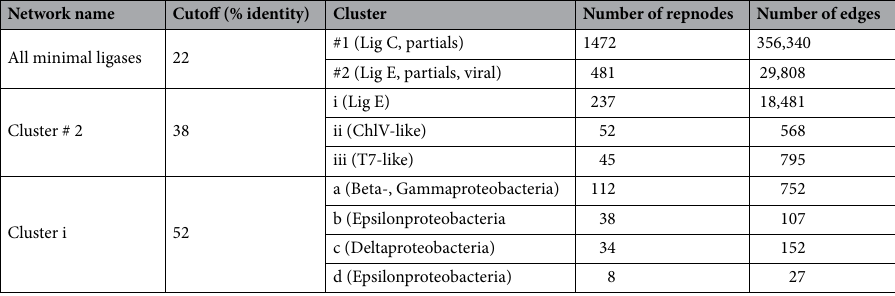
Table 1. Features of Sequence Similarity Networks constructed with DNA ligases 250–370 amino acids